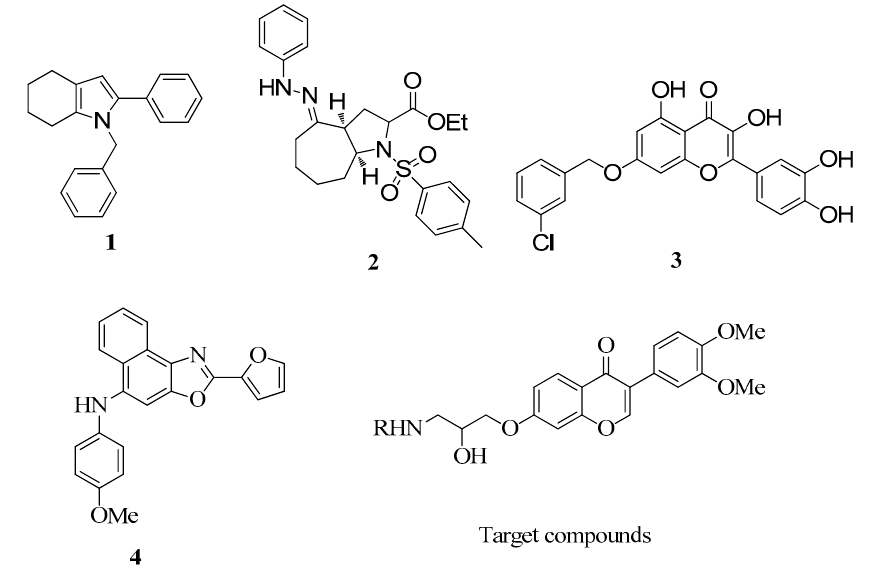
Figure 1. Structures of compounds 1 – 4 , and target compounds.